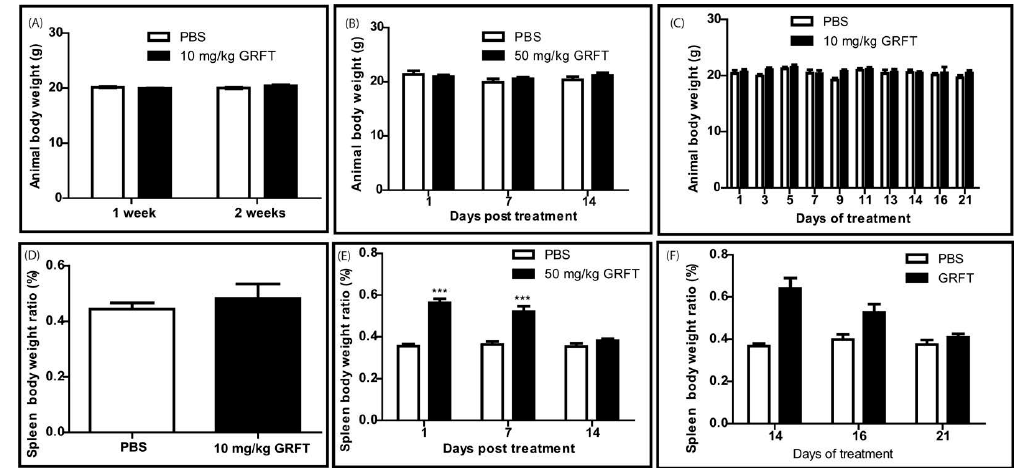
Figure 4. Evaluation of animal fitness and organ toxicity after subcutaneous (s.c.) administration of GRFT in mice. Mice were injected subcutaneously with a single dose of 10 mg/kg ( A , D ); 50 mg/kg ( B , E ), or 14 daily doses of 10 mg/kg GRFT ( C , F ). Animal body weights ( A – C ) and spleen weights ( D – F ) were recorded at the indicated time points (***, p <